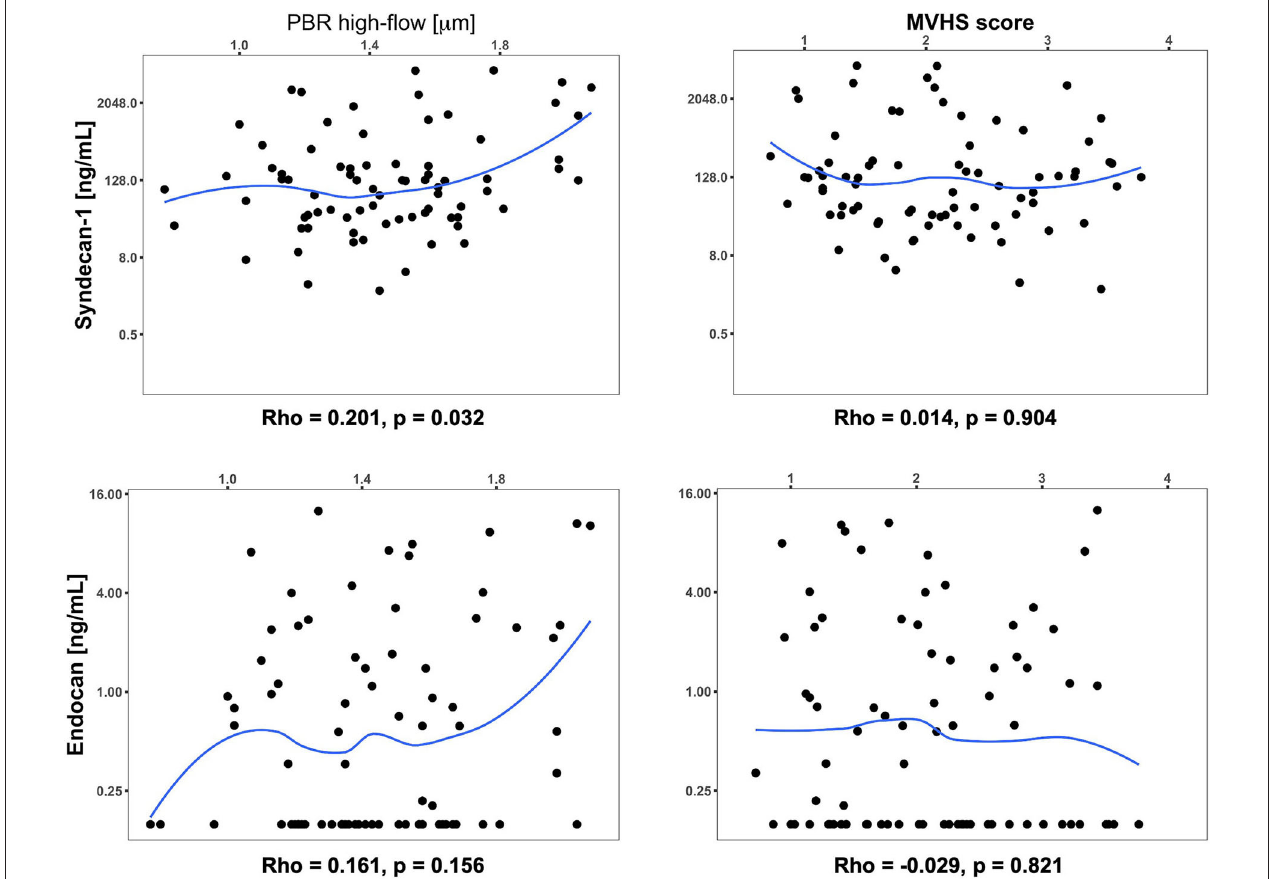
FIGURE 4 | Scatterplot and partial correlation coefficient (Rho) between the respective two parameters of interest controlling for age, sex, and day of illness at measurement. The significance of partial correlations (p) was assessed based on their Fisher transformation and corresponding bootstrap standard errors. Values below the limit of detection for Endocan were imputed as 0.156 ng/mL (detection limit) in this analysis.